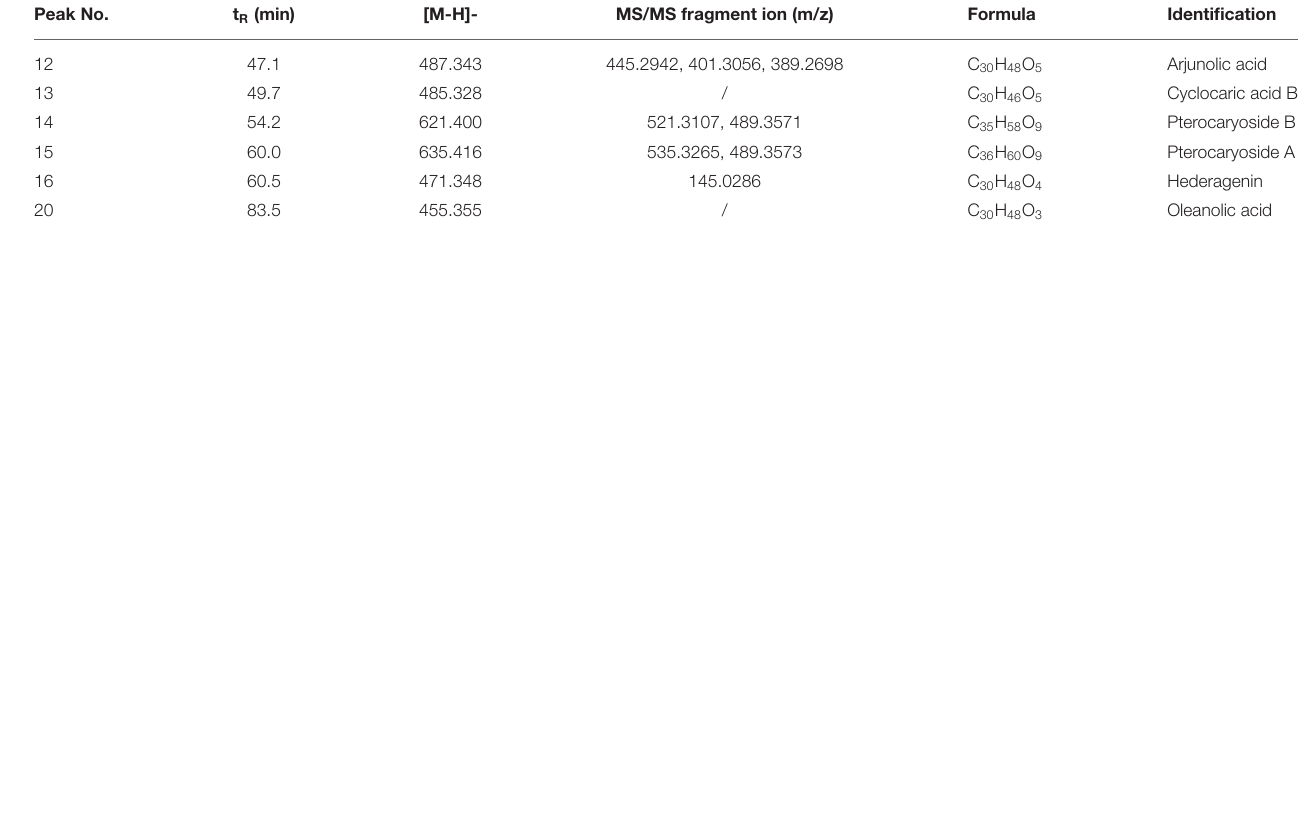
Table A1 | Identification of 6 triterpenoid compounds from leaves of C. paliurus by developed HPLC-Q-TOF-MS. Peak